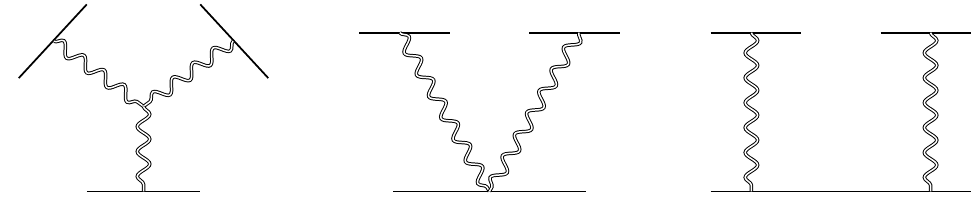
Figure 3 . Feynman diagrams contributing to 3-body scattering of massive scalars (solid lines) in general relativity at O (cid:0) G 2 (cid:1) : (left) Y-type graph, (center) V-type graph, (right) U-type graph. Double wavy lines denote